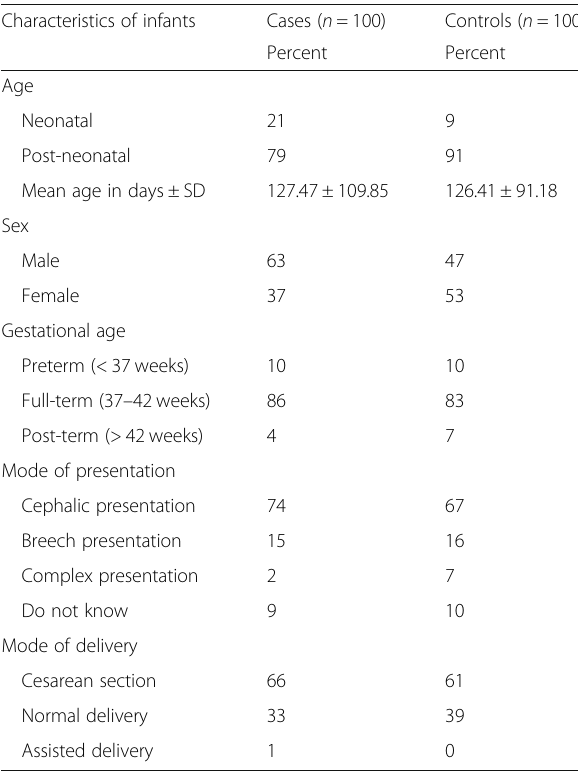
infants than female infants in North England (1985 – Table 3 Characteristics of the studied infants in the Pediatric